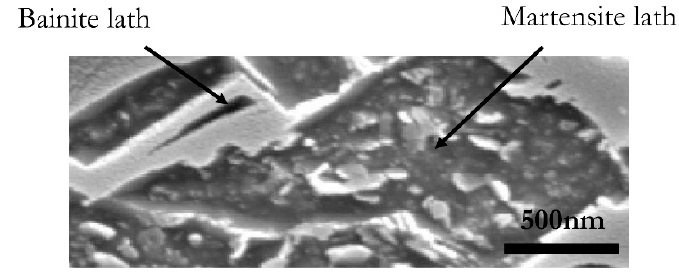
Figure 9. SEM image of a bainite lath together with a martensite lath with poorly defined carbides. Table 3. The different features and characteristics of the other BCT phases in the Q&P microstructure. Feature Characteristics Large laths with carbides